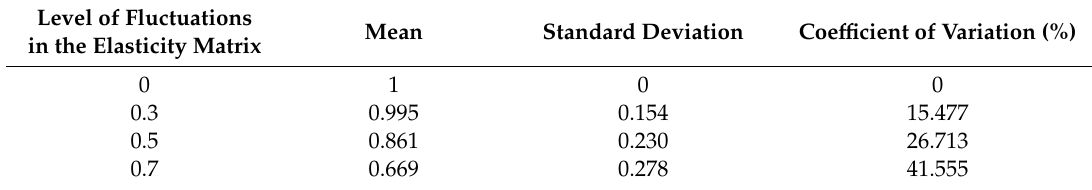
Table 2. Summary of statistical analysis of critical buckling load factor.